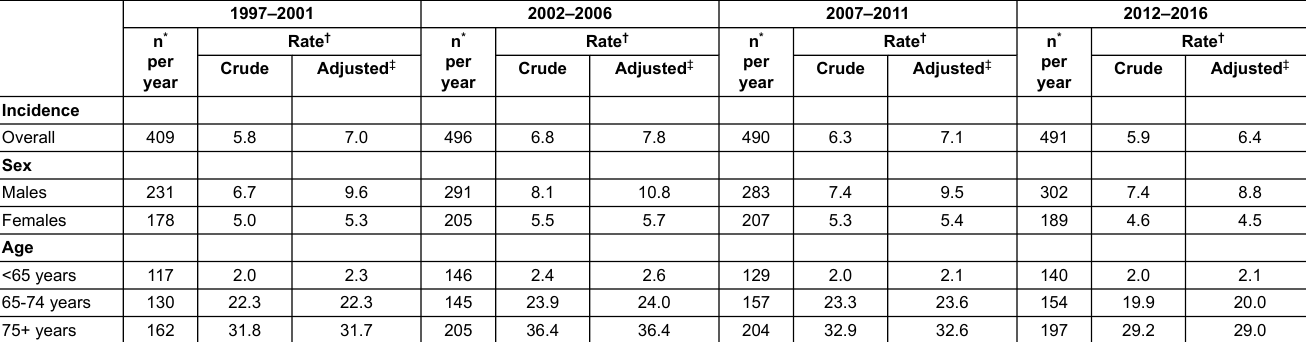
Table S7: Incidence of chronic lymphocytic leukaemia / small lymphocytic lymphoma in Switzerland, 1997–2016 (sensitivity